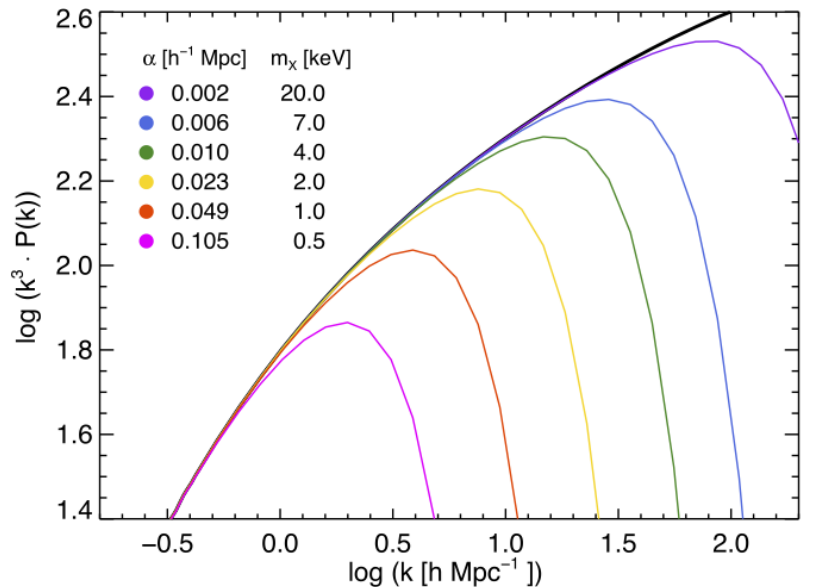
Figure 2. Linear power spectra for Λ CDM (black) and Λ WDM (coloured) scenarios according to their thermal relic mass and damping scale α . For a mass of 2 keV the power spectrum has a cut-off at galactic scales. Image reproduced from